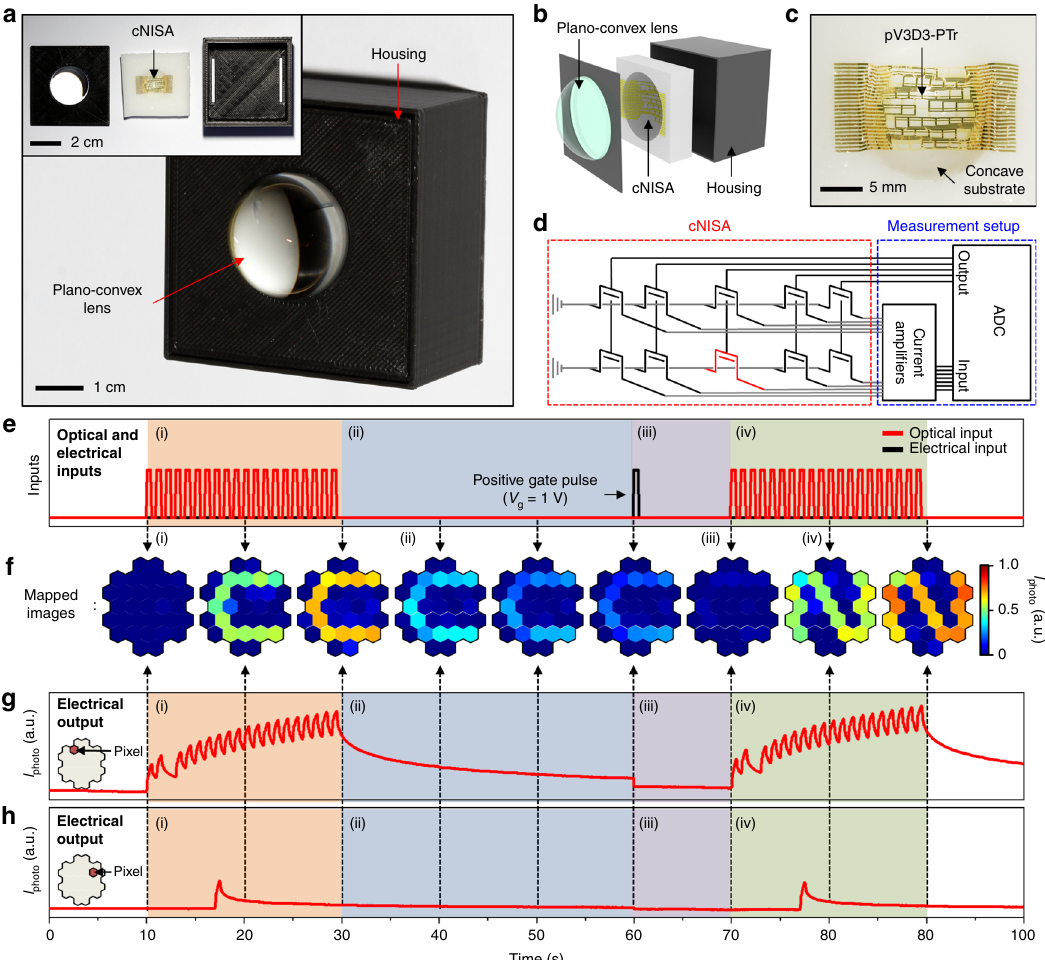
Fig. 4 Fully integarted form of the curved neuromorphic imaging device. a Photograph of an integrated imaging system that consists of a plano-convex lens, cNISA, and a housing. The inset shows the components before assembly. b Exploded illustration of the curved neuromorphic imaging device. c Photograph of cNISA on a concave substrate. d Schematic diagram of the customized data acquisition system for measuring the photocurrents of individual pixels in cNISA. e – h Demonstrations for deriving a pre-processed image from massive noisy optical inputs (e.g., acquisition of a pre-processed C-shape image (i), decay of the memorized C-shape image (ii), erasure of the afterimage (iii), and acquisition of a pre-processed N-shape image (iv)). Figure 4e shows applied optical inputs and an applied electrical input. Figure 4f shows obtained images at each time point. Figure 4g and h show the photocurrent obtained from the pointed pixels at each time